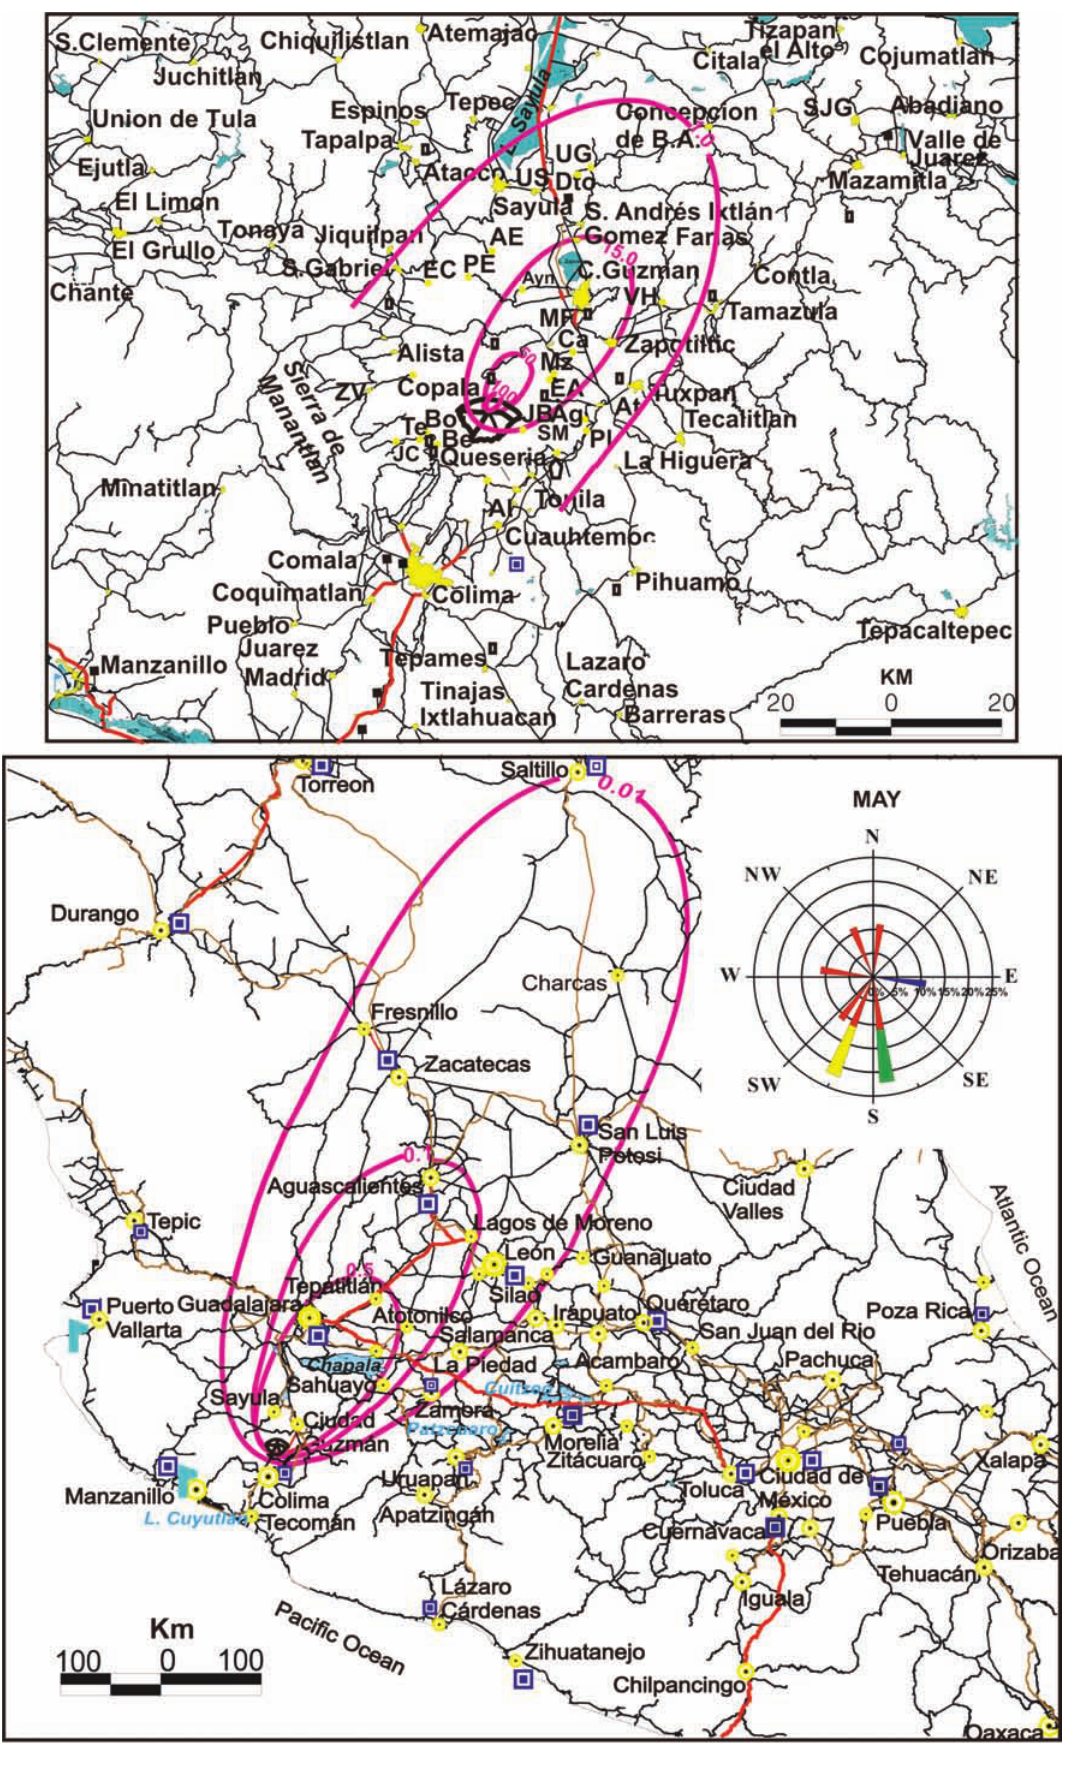
Figure 6. Scenario 3. For an eruption in May, showing the first potential, north-northeast, area that would be affected by a future Plinian eruption. For details, see legend to Figure